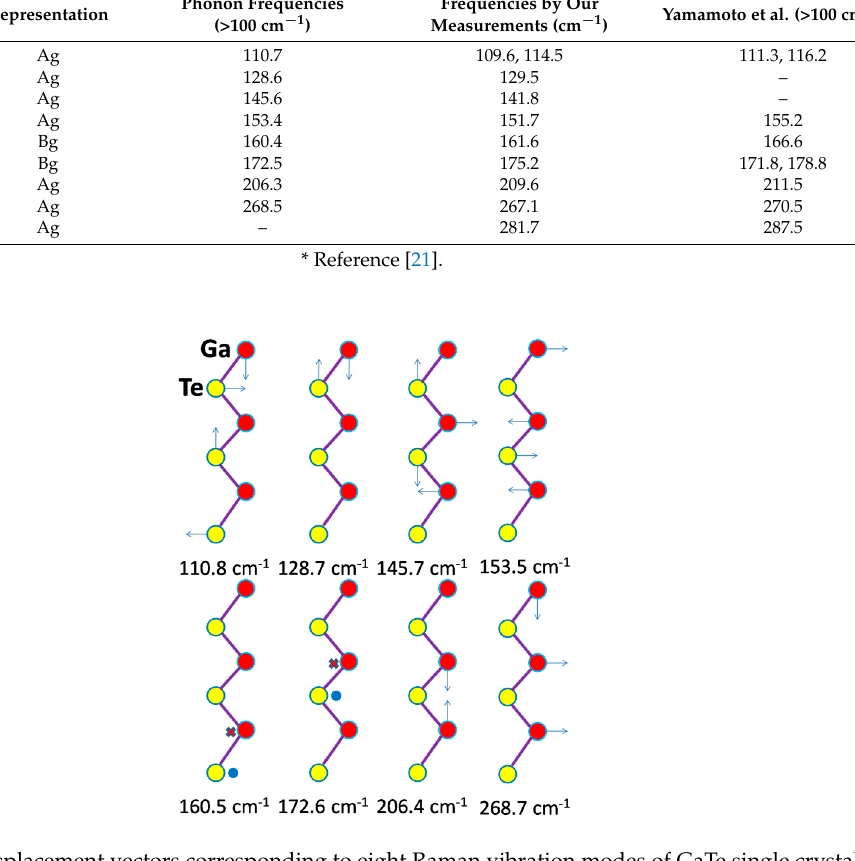
Figure 3. Displacement vectors corresponding to eight Raman vibration modes of GaTe single crystals.